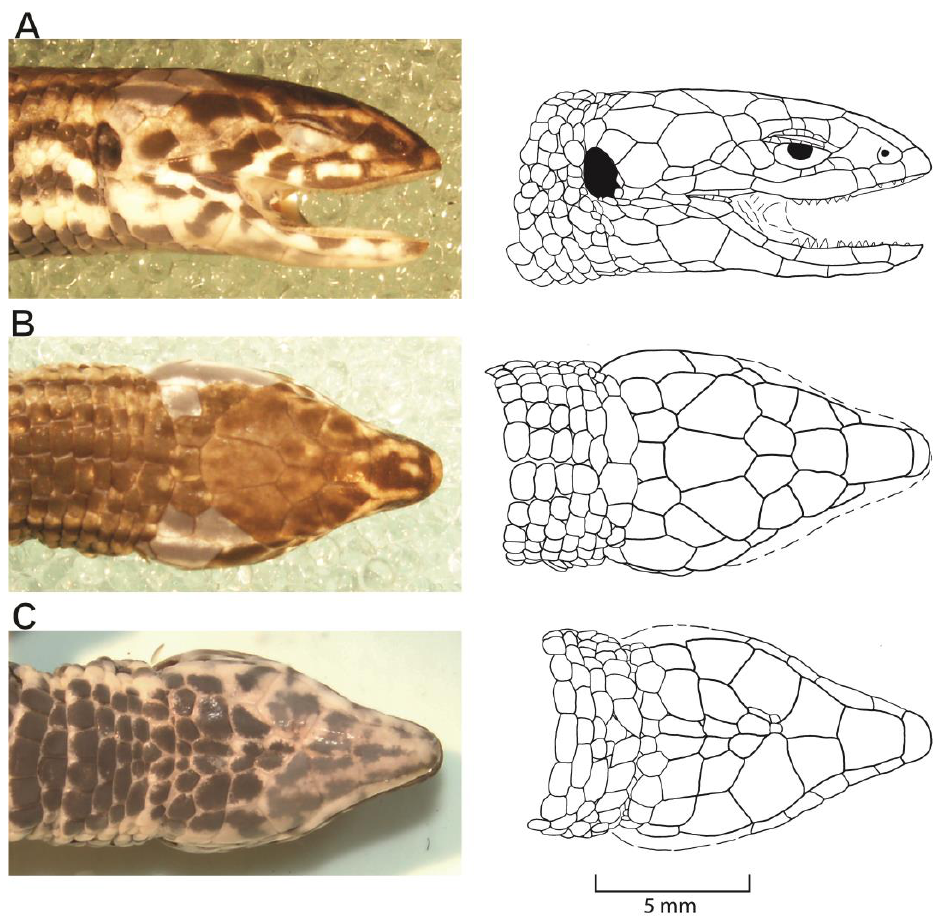
Figure 6. Photos (left column) and drawings (right column with scale) of the head of Proctoporus titans sp. nov. (MUSM 40916, holotype) in lateral ( A ), dorsal ( B ), and ventral ( C ) views. Head length 10.7 mm.